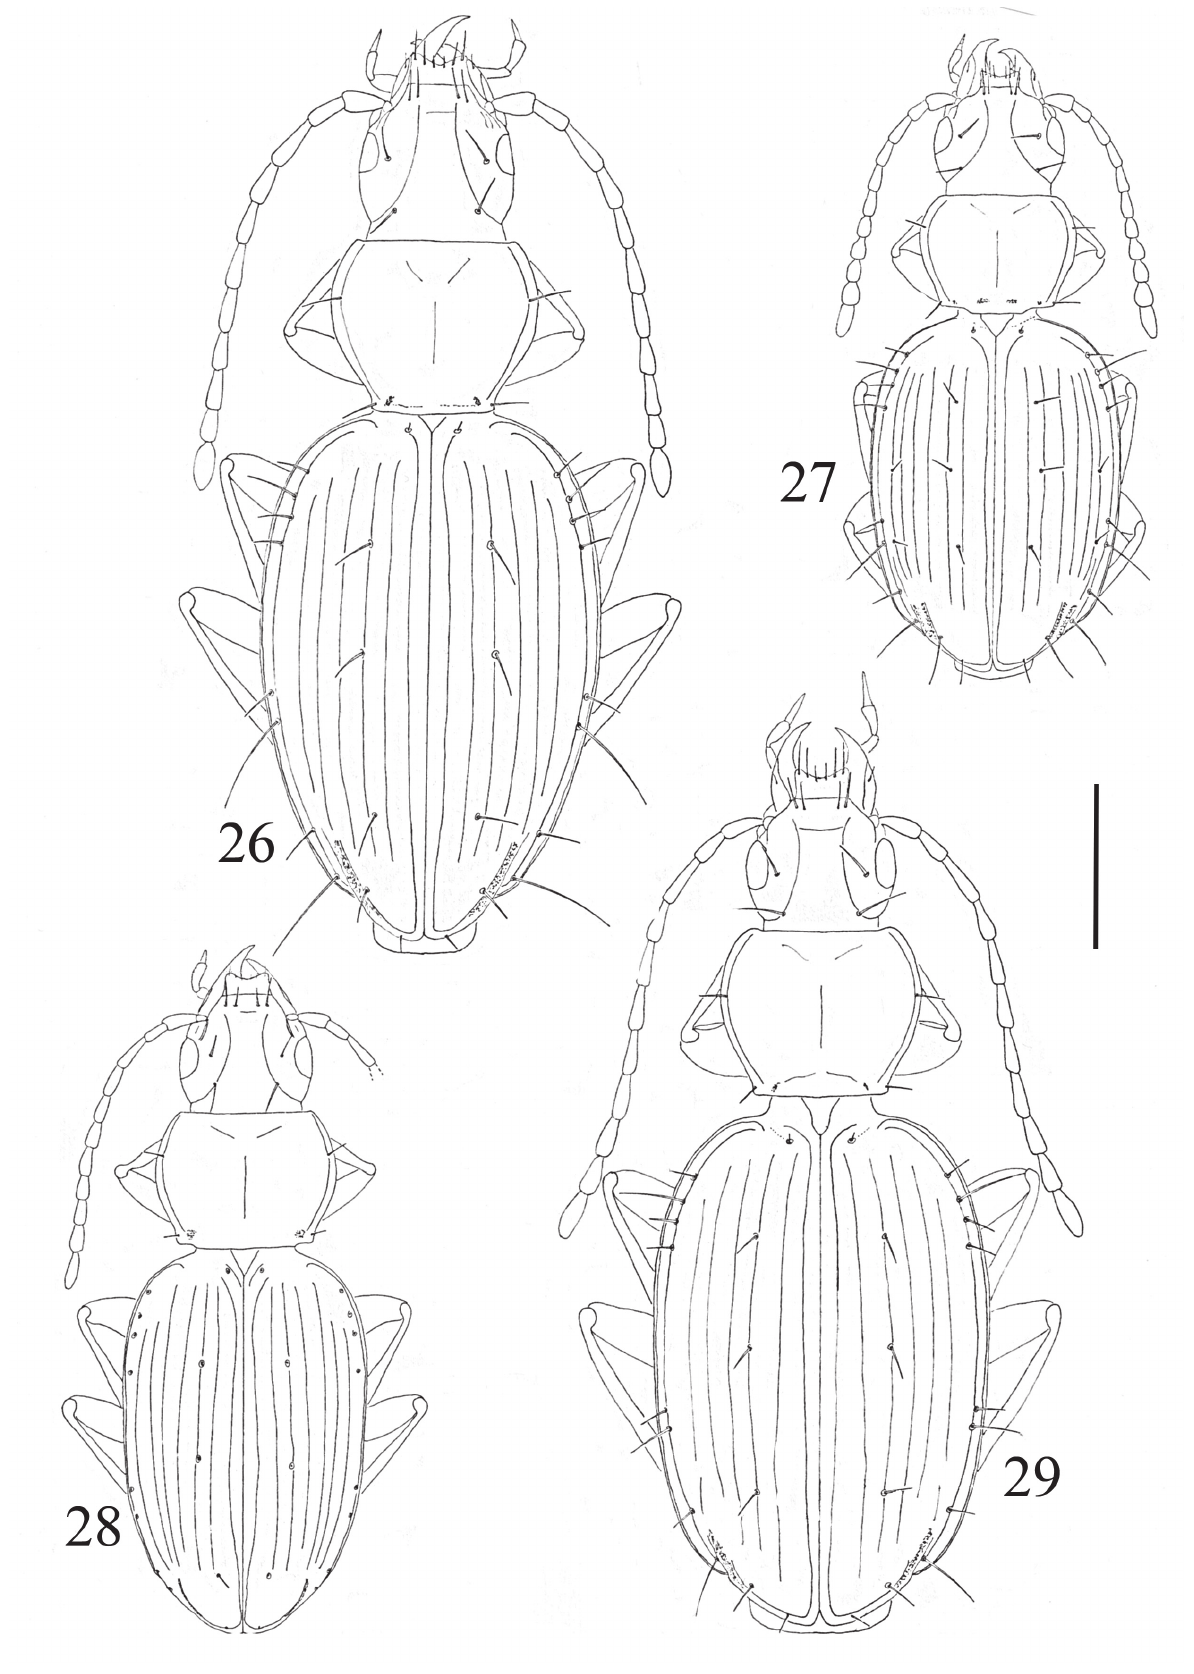
Figs 26-29. Habitus of Tasmanorites spp.: 26) T. elegans Moore, ♀ from Elephant Fram Cave; 27) T. aberrans Moore, ♂ from Pillinger, Kelly Cove; 28) T. austrinus (Sloane), HT ♂ from Great Lake; 29) T. magnus Moore, ♂ from Ben Lomond. Scale: 1